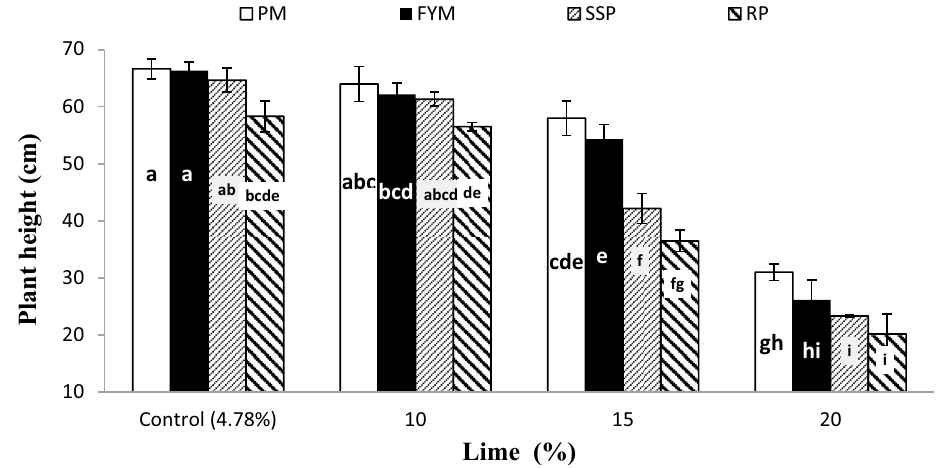
Figure 4. Interactive effect of lime and P sources on plant height. Graph bars having different letters are significantly different at α = 0.05. Errors bar represent standard error for the mean of three values.